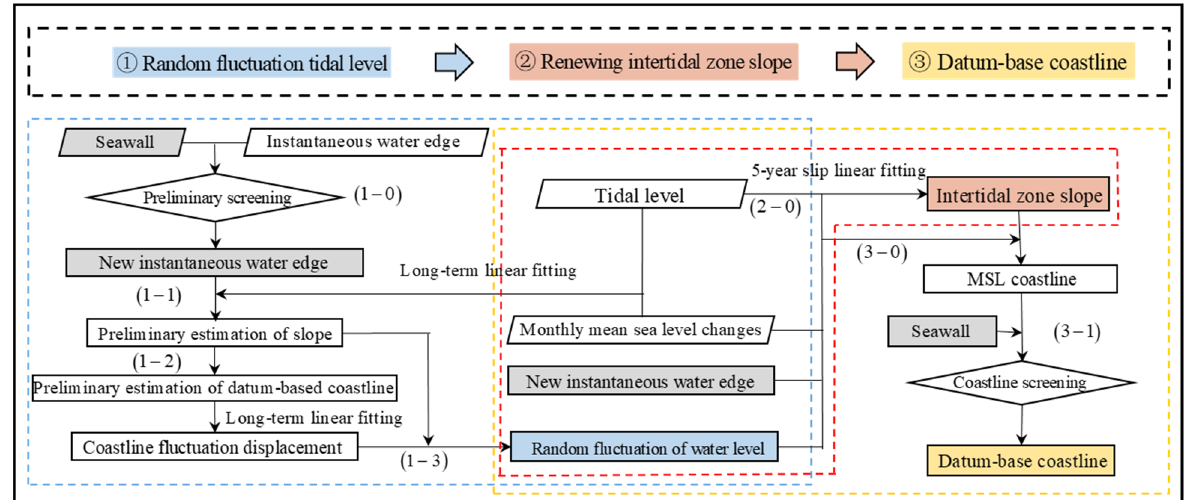
Figure 3. Procedure of the coastline correction algorithm.